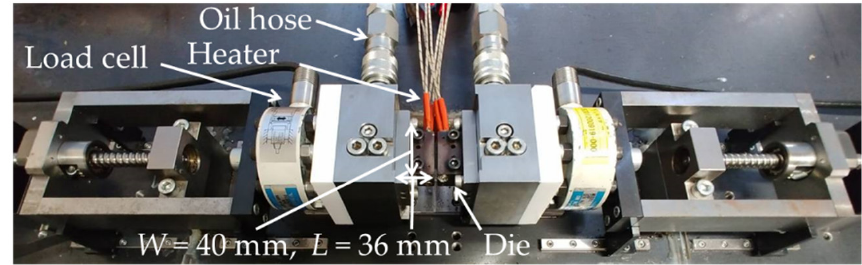
Figure 1. Appearance of the small warm hydroforming system used for the experiments.